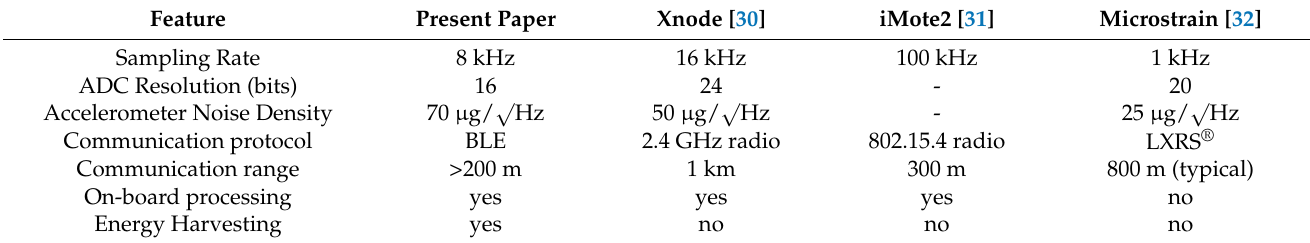
Table 1. Comparison between different wireless sensors available in